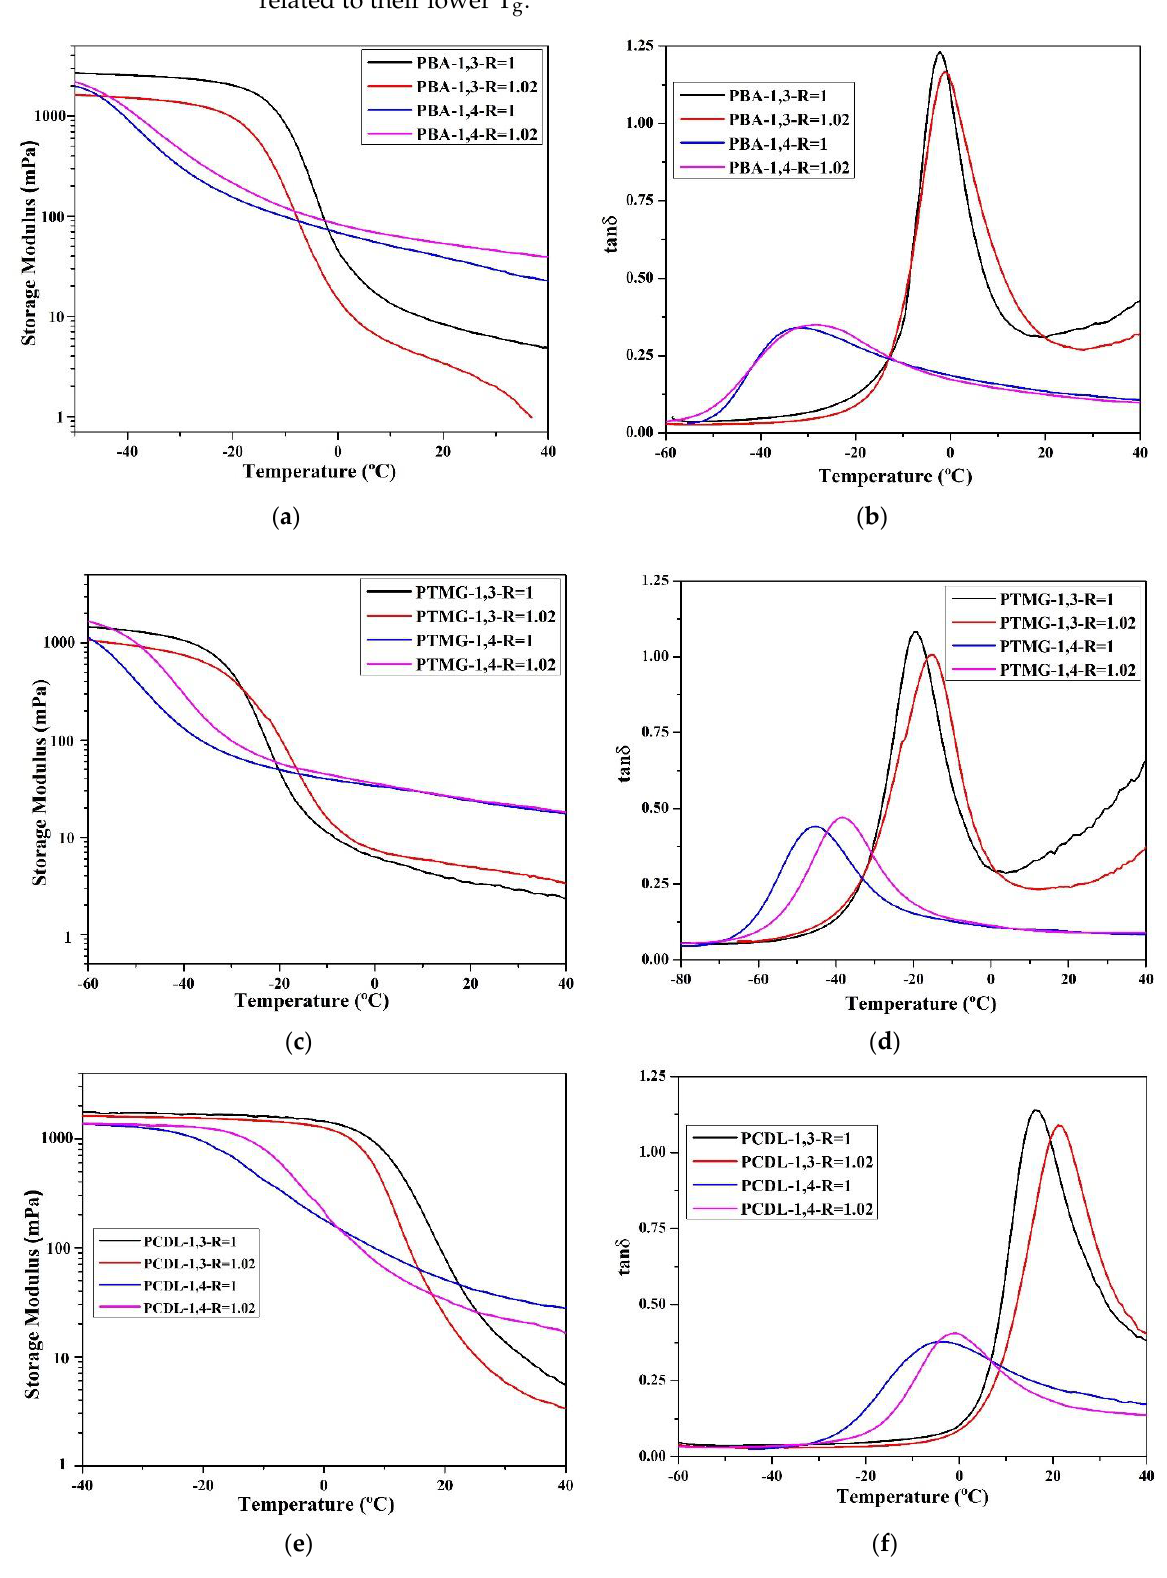
Figure 4. According to dynamic mechanical analysis (DMA), the following parameters were measured: storage modulus (mPa) and tan δ related to the temperature rate; storage modulus ( a ) and tan δ ( b ) of TPU from PBA, storage modulus ( c ) and tan δ ( d ) of TPU from PTMG; storage modulus ( e ) and tan δ ( f ) of TPU from PCDL.